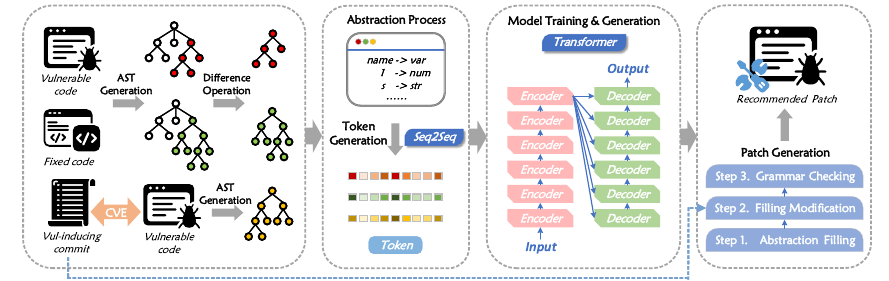
Fig. 2 Overview of our approach